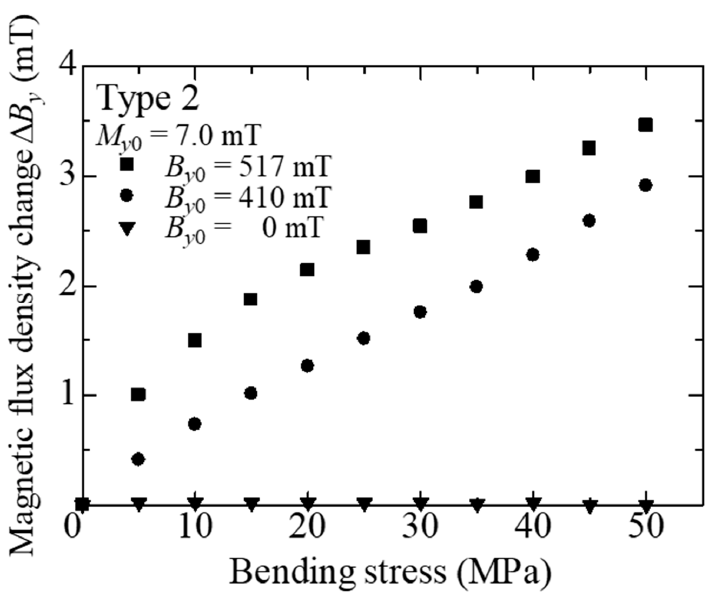
Figure 9. Magnetic flux density change ∆ B y versus bending stress of Type 2 sample under various bias magnetic fields B y 0 .